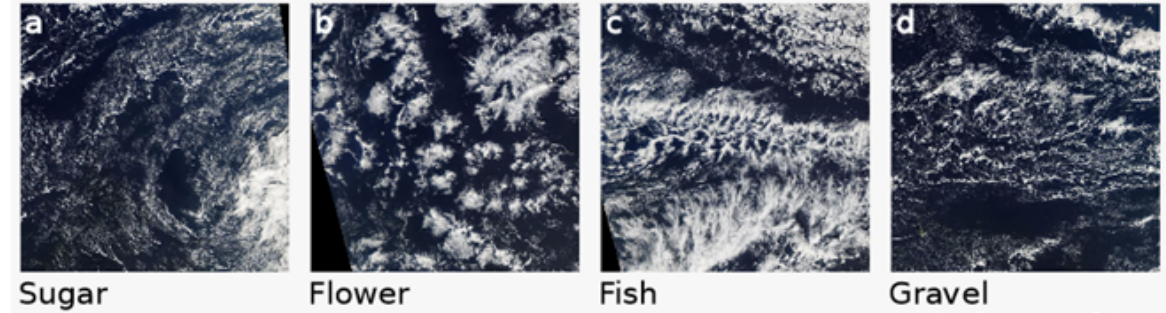
Figure 1. Cloud pattern dataset containing patterns of Sugar ( a ), Flower ( b ), Fish ( c ) and Gravel ( d